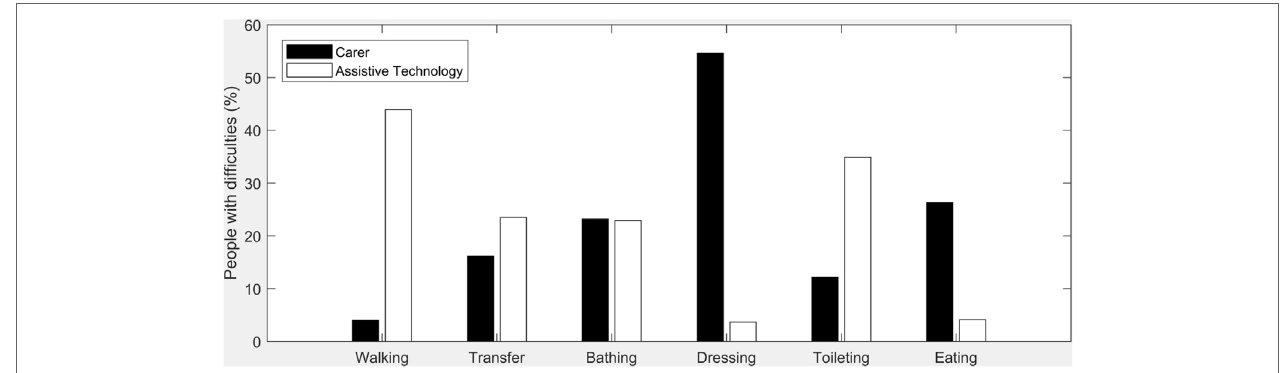
FigUre 1 | Percentage of people having difficulties with activities of daily living (aDls) who have carer assistance (black) and those using assistive technology (white) . Assistive technology for walking is relatively advanced and low cost hence little need for carers, where dressing is contrary to this situation [data from Dudgeon et al.